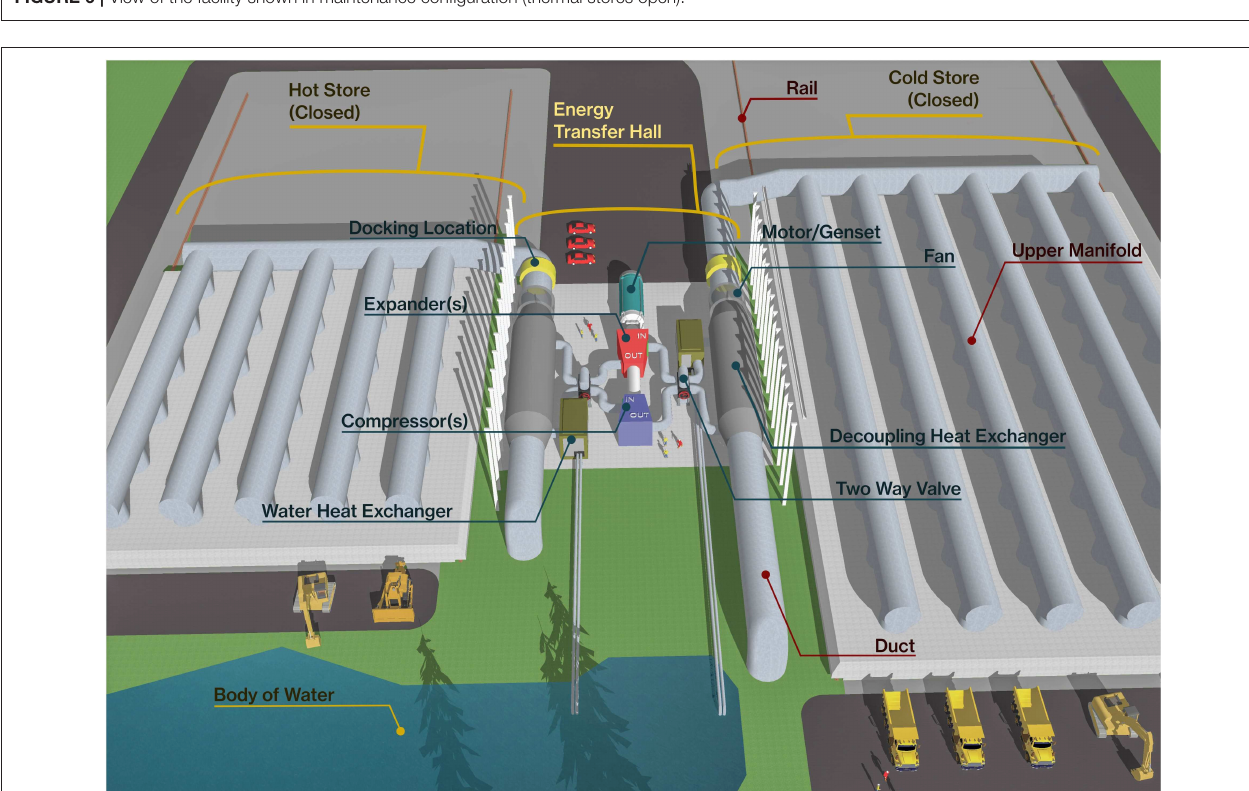
FIGURE 7 | View of the Energy Transfer Hall and thermal stores shown in operating configuration.